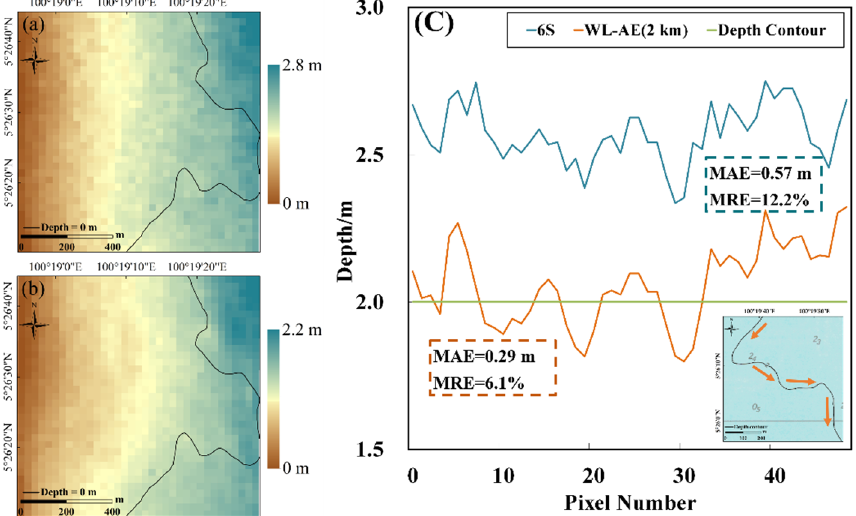
Figure 9. Bathymetric inversion results of Penang. ( a ) is the inversion result corresponding to 6S for the 0-m area; ( b ) is the inversion result corresponding to WL-AE for the 0 m area; ( c ) is the plot of the inversion results obtained at the 2 m isobaths, where the depth values on the isobaths are extracted in the direction shown by the arrow in the lower-right chart.